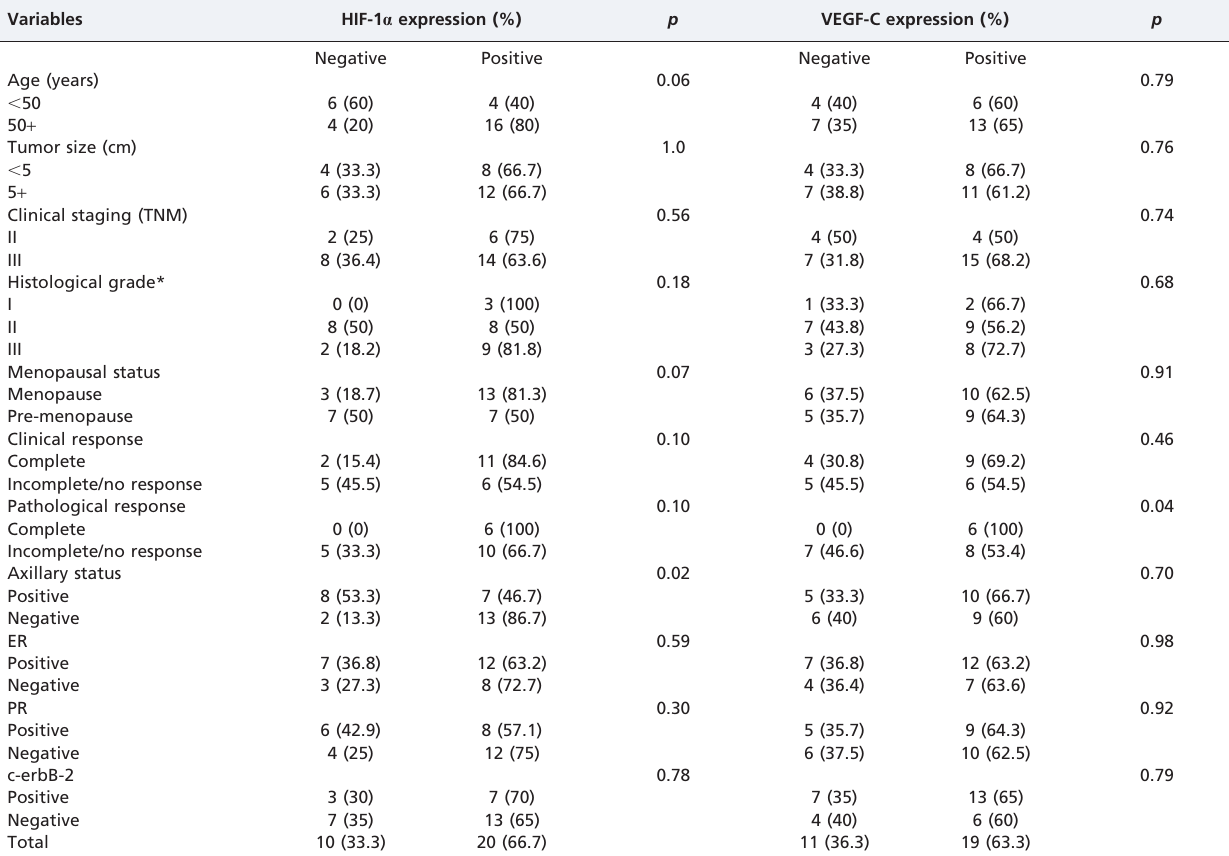
Table 2 - The association between HIF-1 a /VEGF-C expression and clinical variables (Ribeira˜o Preto, Brazil, 2010). Variables